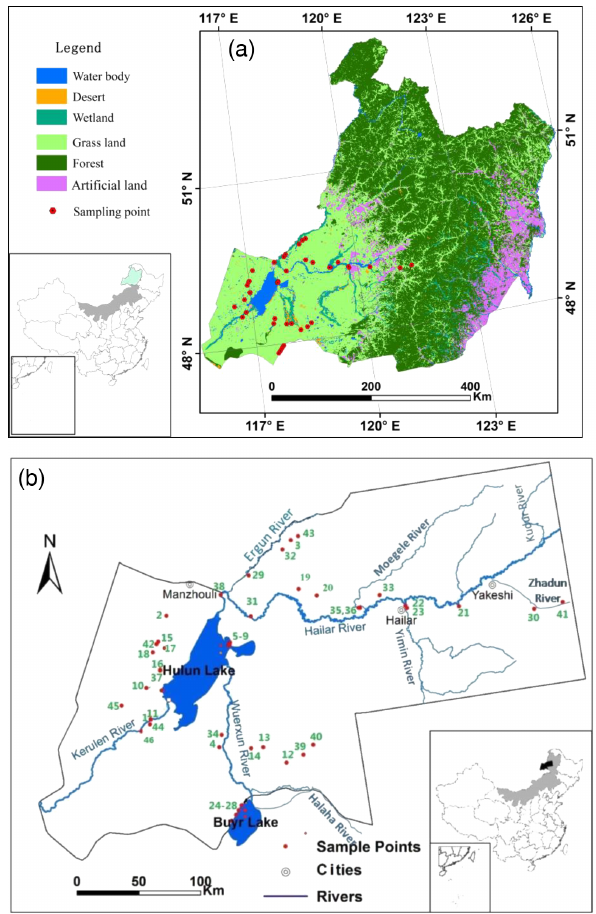
Figure 1. Study area location and sampling station